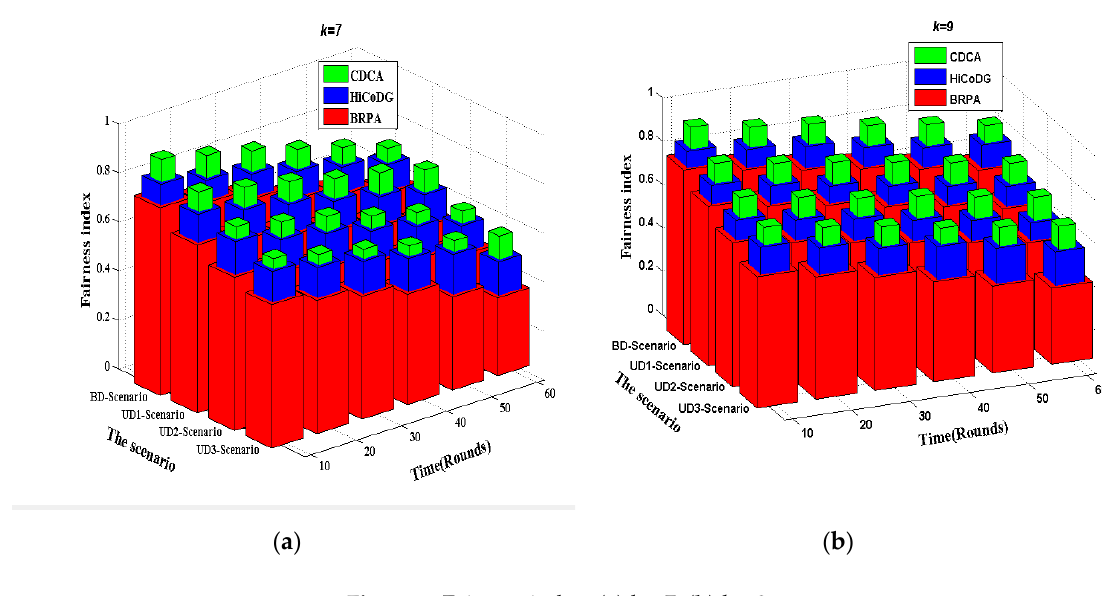
Figure 6. Fairness index. ( a ) k = 7; ( b ) k = 9.